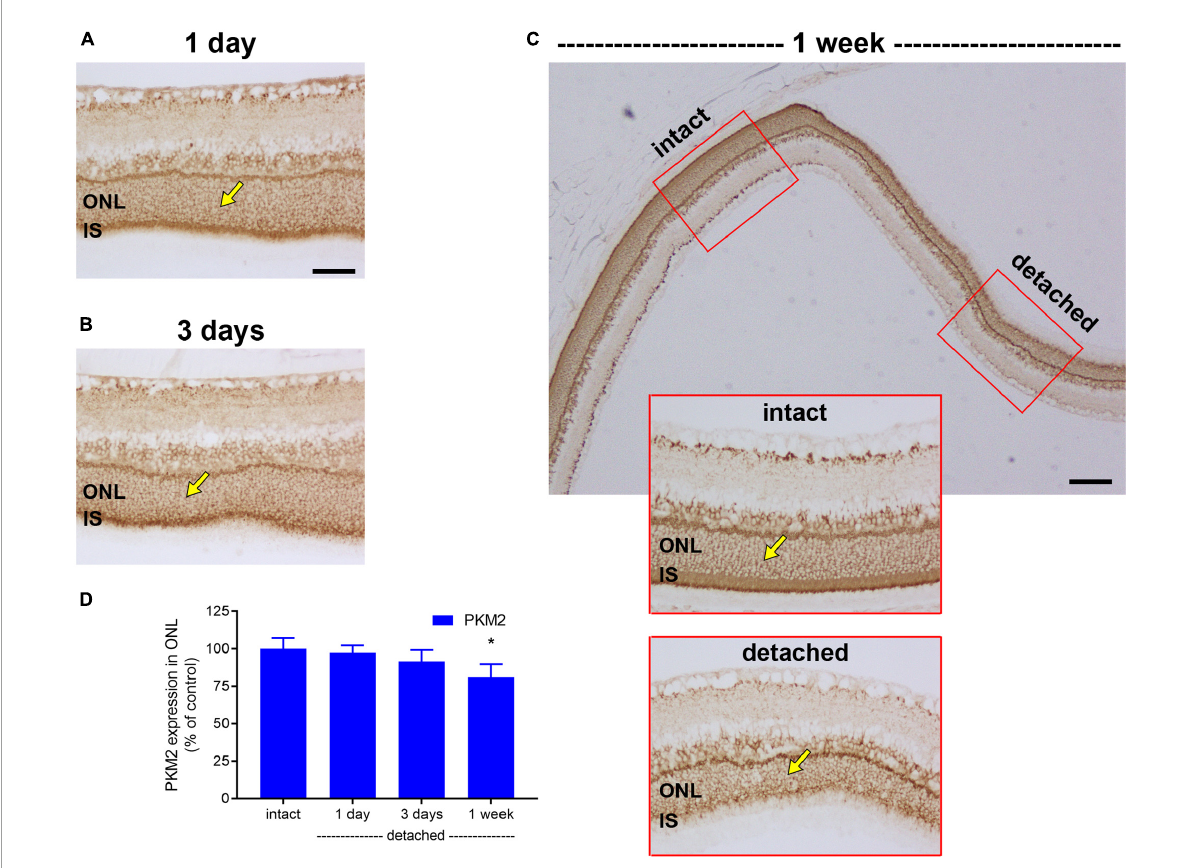
FIGURE5 Effect of retinal detachment on expression of pyruvate kinase M2 isozyme (PKM2), as evaluated by immunohistochemistry. (A–C) Representative images of PKM2 immunolabelling in intact retina, and at 1 day, 3 days, and 1 week after detachment. Arrows demarcate photoreceptor cell bodies. (D) Quantification of PKM2 immunoreactivity within the outer nuclear layer (ONL) at 1 day, 3 days, 1 week, and 4 weeks after retinal detachment. Values, shown as % of the intact group, represent mean ± SEM. * P < 0.05 by Student’s unpaired t -test followed by modified Bonferroni correction (intact vs. detached). Scale bars: (A–C) (insets) = 60 µ m; (C) (overview) = 150 µ m. IS, inner